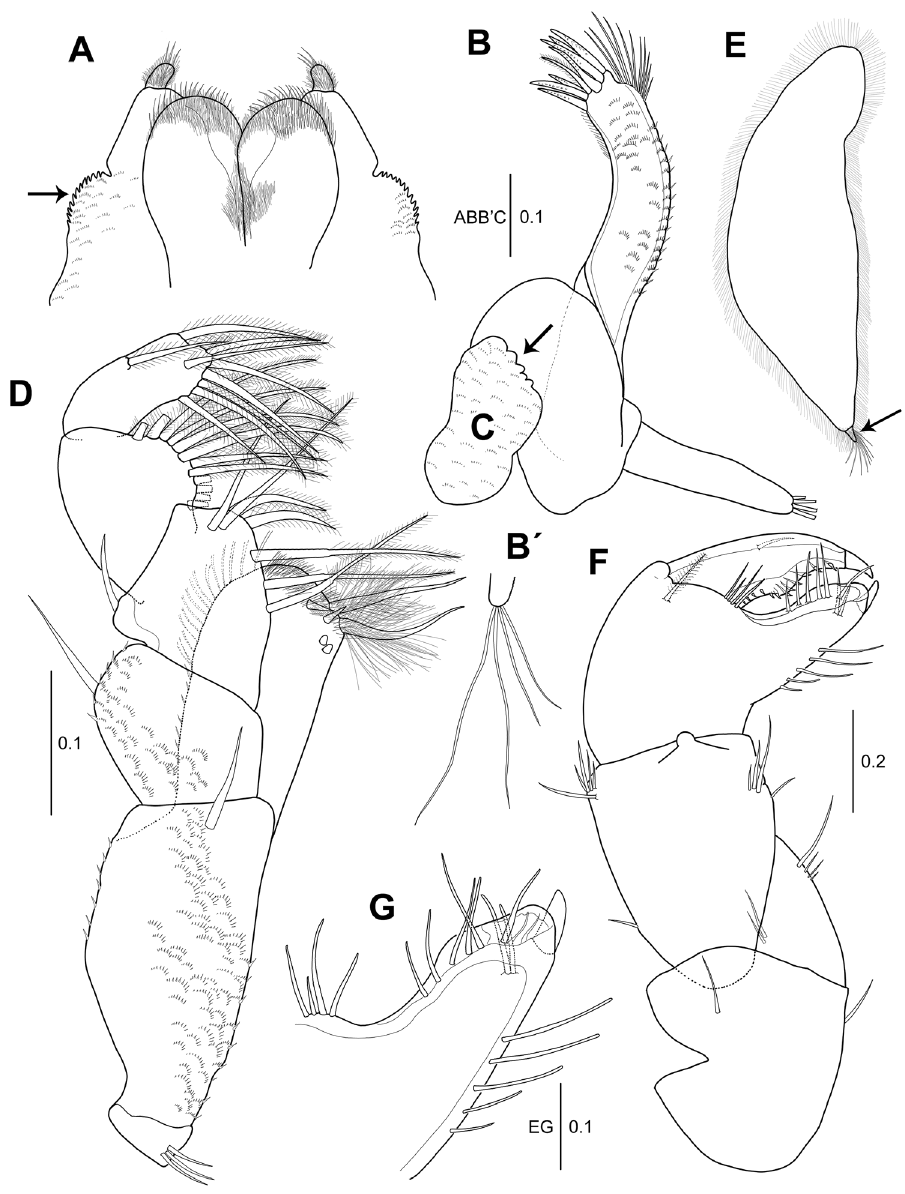
Figure 2. Hexapleomera ulsana sp. n., female holotype A labium B maxillule B´ distal setae of maxillule palp C maxilla D maxilliped E epignath F cheliped G fixed finger of cheliped. Scale bars are given in mm. subdistal setae and one dorso-subproximal and five dorsodistal setae. Propodus 1.3 times as long as carpus, 1.9 times as long as wide, with one plumose inner seta and four simple setae near insertion of dactylus. Fixed finger with five simple ventral